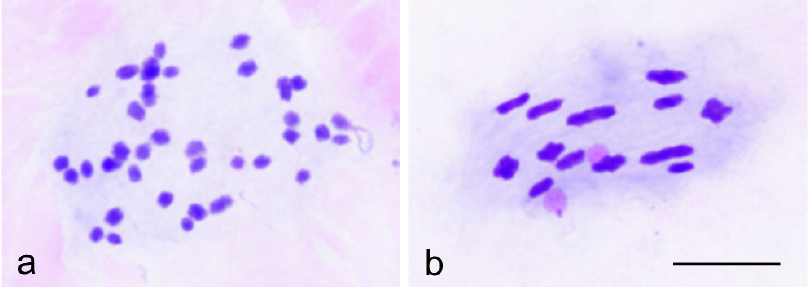
Figure 2. ( a , b ). Prometaphase in mature eggs of female C. ledi . ( a ) Triploid apomictic female showing